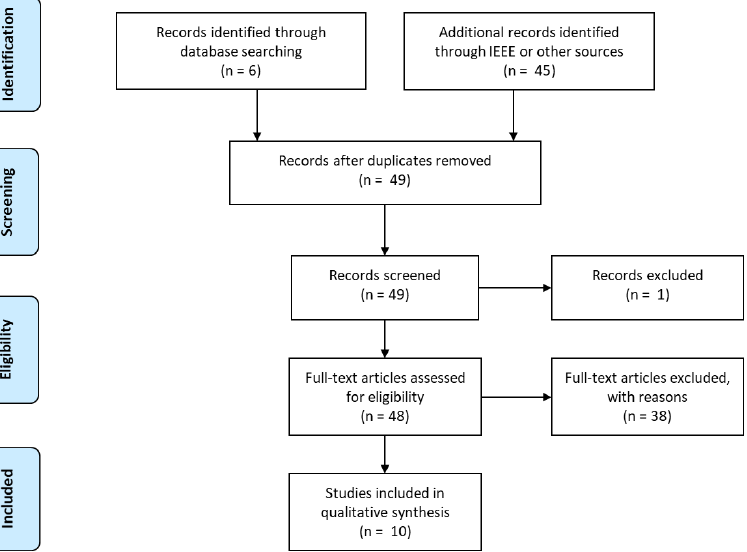
Figure 2. Flow diagram of the search results of the second topic following the PRISMA protocol [82].